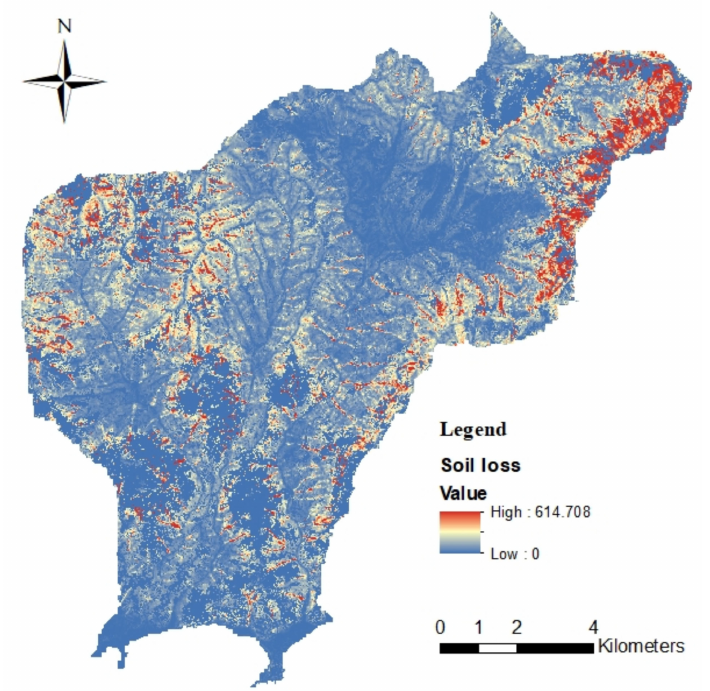
Figure 17. Soil loss map produced using R from the Global Precipitation Measurements (GPM) and C from NDVI (r) data.